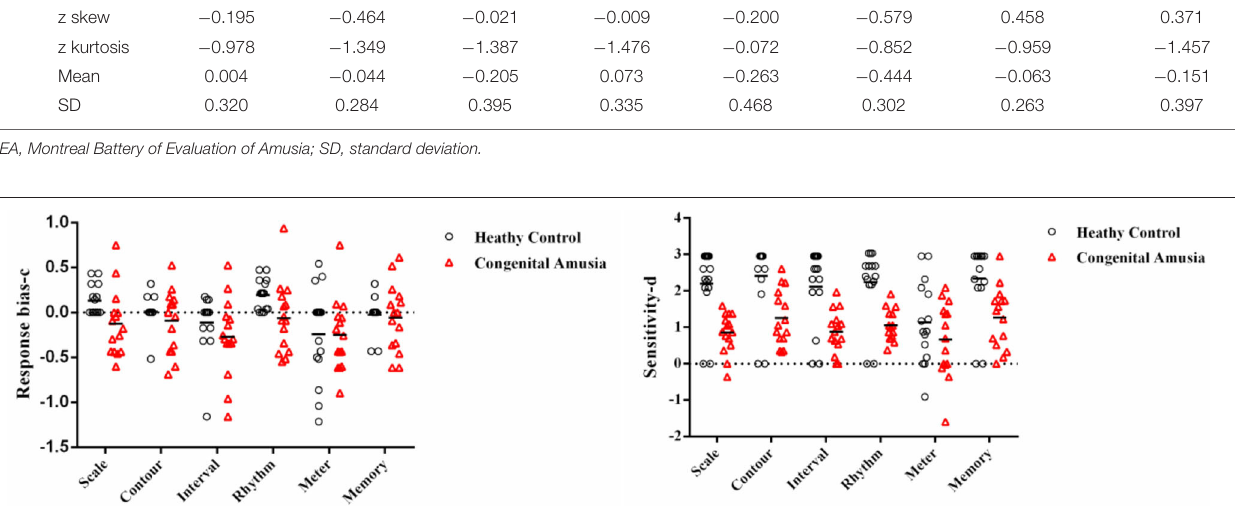
FIGURE 2 | Signal Detection Theory scores (d’ and c) plotted in per subtest. The categorization based on PC scores. The c value of scale subtest ( p = 0.018) and rhythm subtest ( p = 0.020) in the congenital amusia group is lower than the healthy controls. The d’ value of the scale subtest ( p = 0.000), contour subtest ( p =